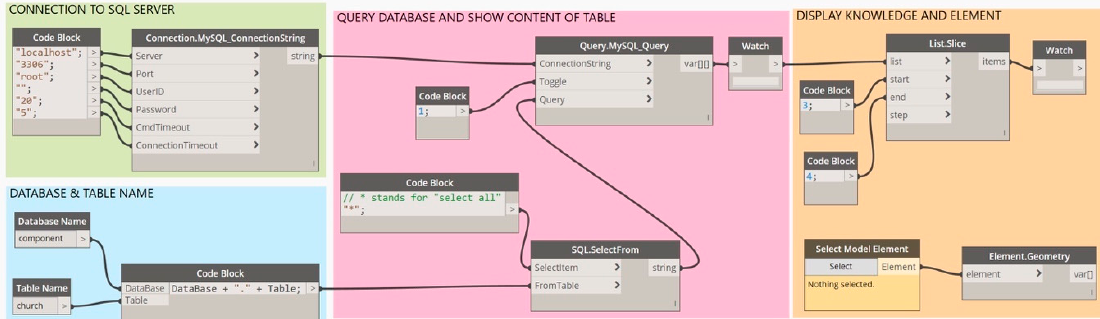
Figure 9. The connection of HBIM elements and ontological knowledge based on Revit Dynamo, where the corresponding knowledge of the element selected in Revit can be displayed in the “ watch ” window.